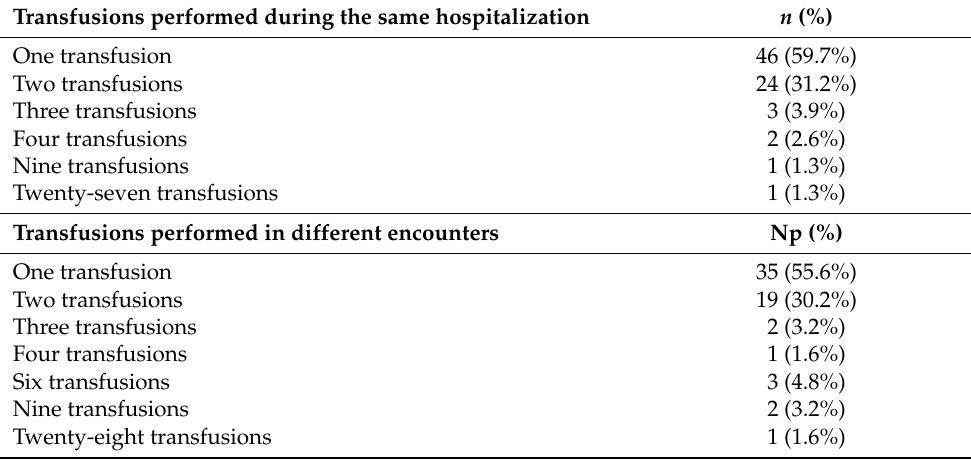
Table 2. Number of blood transfusions to a single patient during one hospitalization ( n = 147) or in different encounters (Np = 77) between